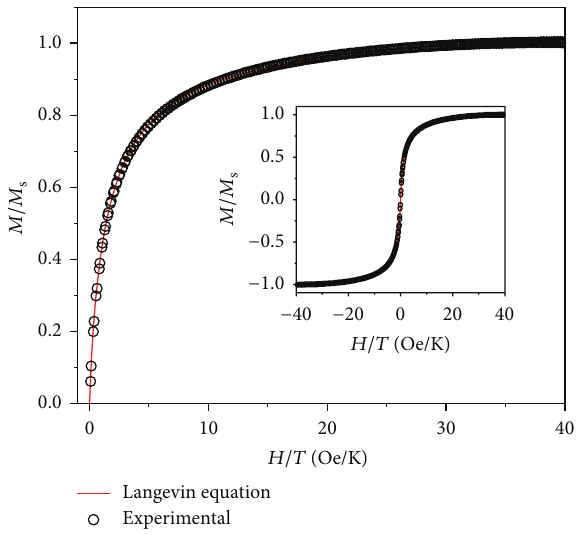
Figure 6: Normalized magnetization curve of magnetite ( I ) fitted with a Langevin function (solid line); the used parameters were 𝜇 0 = 𝑇 = 300 K, and 𝜎 = 1.24 1705 𝜇 B ,